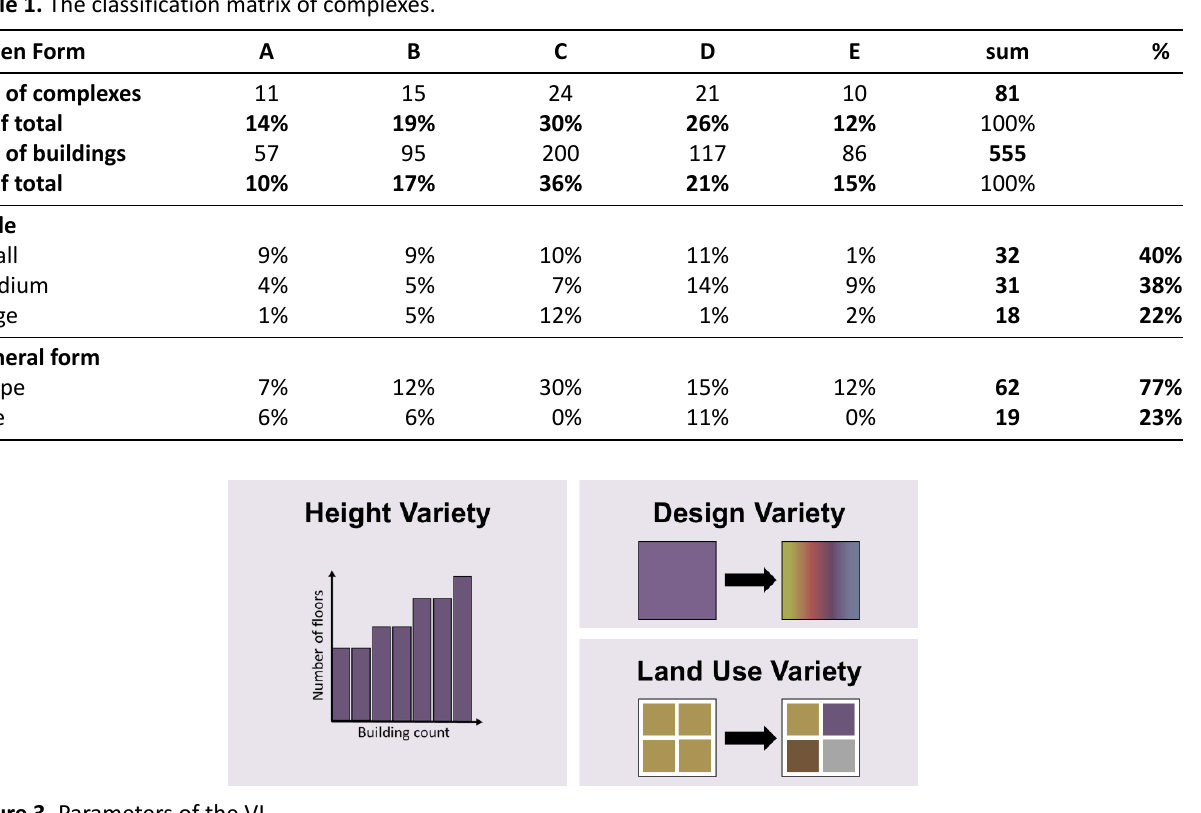
Figure 3. Parameters of the